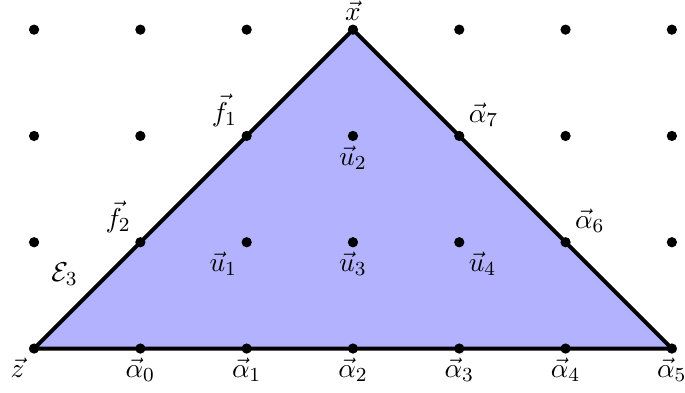
Figure 8 . The facet of the E E 8 -top over the edge 3 . The four vectors in the interior give rise to a rank four theory in 5d. The divisors corresponding to ~f i resolve the SU(3) (cid:12)ber singularities of the elliptic (cid:12)bration over f s 8 g